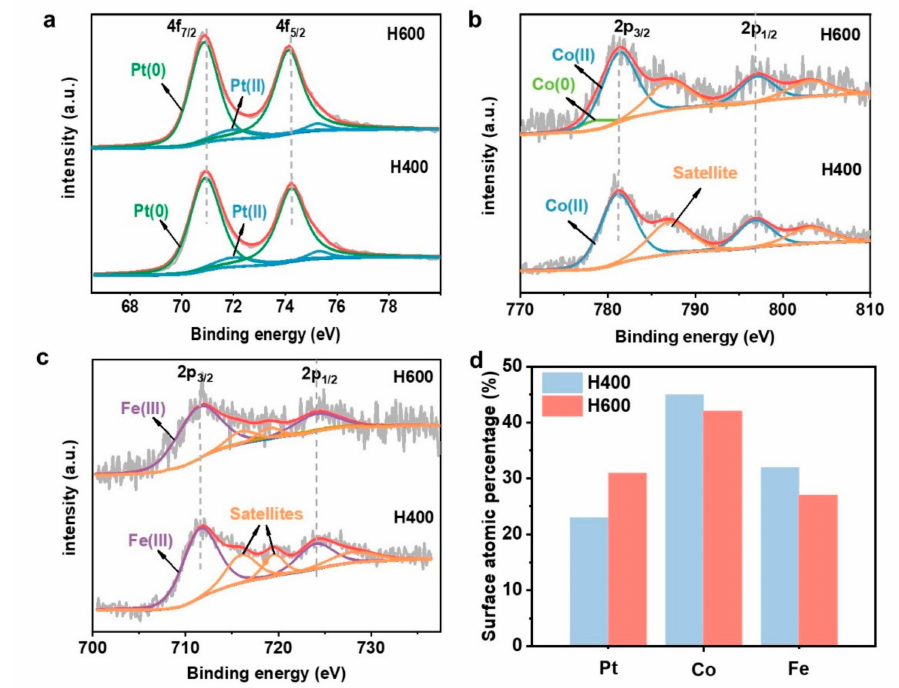
Figure 2. X-ray photoelectron spectroscopy (XPS) spectra of Pt-4f ( a ), Co-2p ( b ), Fe-2p ( c ), and the surface atomic composition ( d ) of Pt, Co, and Fe in the PtCoFe-H400 and PtCoFe-H600